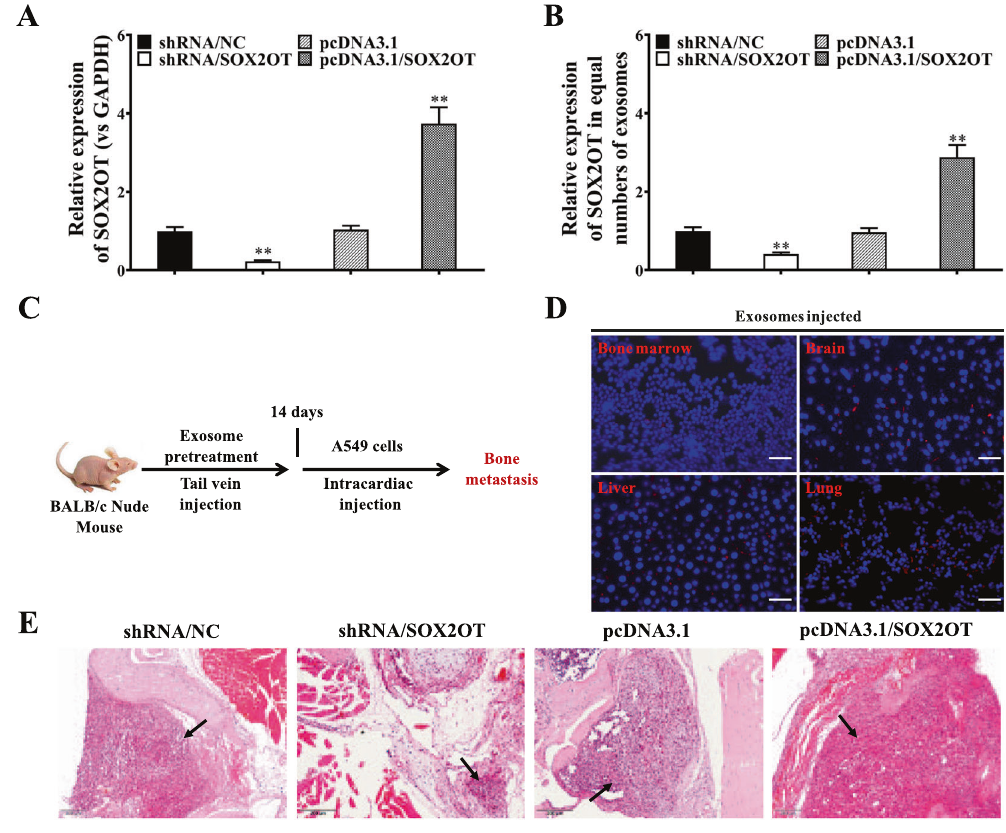
Fig. 2 LncRNA-SOX2OT-enriched exosomes promote NSCLC BoM. A , B LncRNA-SOX2OT expression was evaluated by real-time PCR in the cytoplasm and exosomes of lncRNA-SOX2OT-knockdown and lncRNA-SOX2OT-overexpressing A549 cells and their respective controls. GAPDH was used as the internal control. Data are representative of three biological replicates. C The protocol for studying the tissue distribution of exosomes is shown. Exosomes were administered to BALB/c nude mice by tail vein injection. D In vivo tracing of injected exosomes in the lungs, liver, bone marrow and brain of mice was performed. RAW264.7 cells were incubated with PKH-26-labelled exosomes (red fl uorescent) derived from A549 cells. Nuclei were stained with 4 ′ ,6-diamidino-2-phenylindole (DAPI). The incorporation of red fl uorescent exosomes into the targeted RAW264.7 cells was observed under a fl uorescence microscope. E For the NSCLC BoM experiment, BALB/c nude mice were pre-treated with exosomes (10 μ g/mouse) containing different amount of lncRNA-SOX2OT every other day for 4 weeks by tail vein injection. Subsequently, A549 cells were injected into the left cardiac ventricle to establish experimental BoM models. The effect of lncRNA- SOX2OT-enriched exosomes on BoM was analysed by staining tissue sections with H&E. Black arrows indicate the metastatic foci and cancerous cells in the representative images. Scale bar, 200 μ m. Each experiment was performed at least three times independently. *, P < 0.05; **, P < 0.01 (t